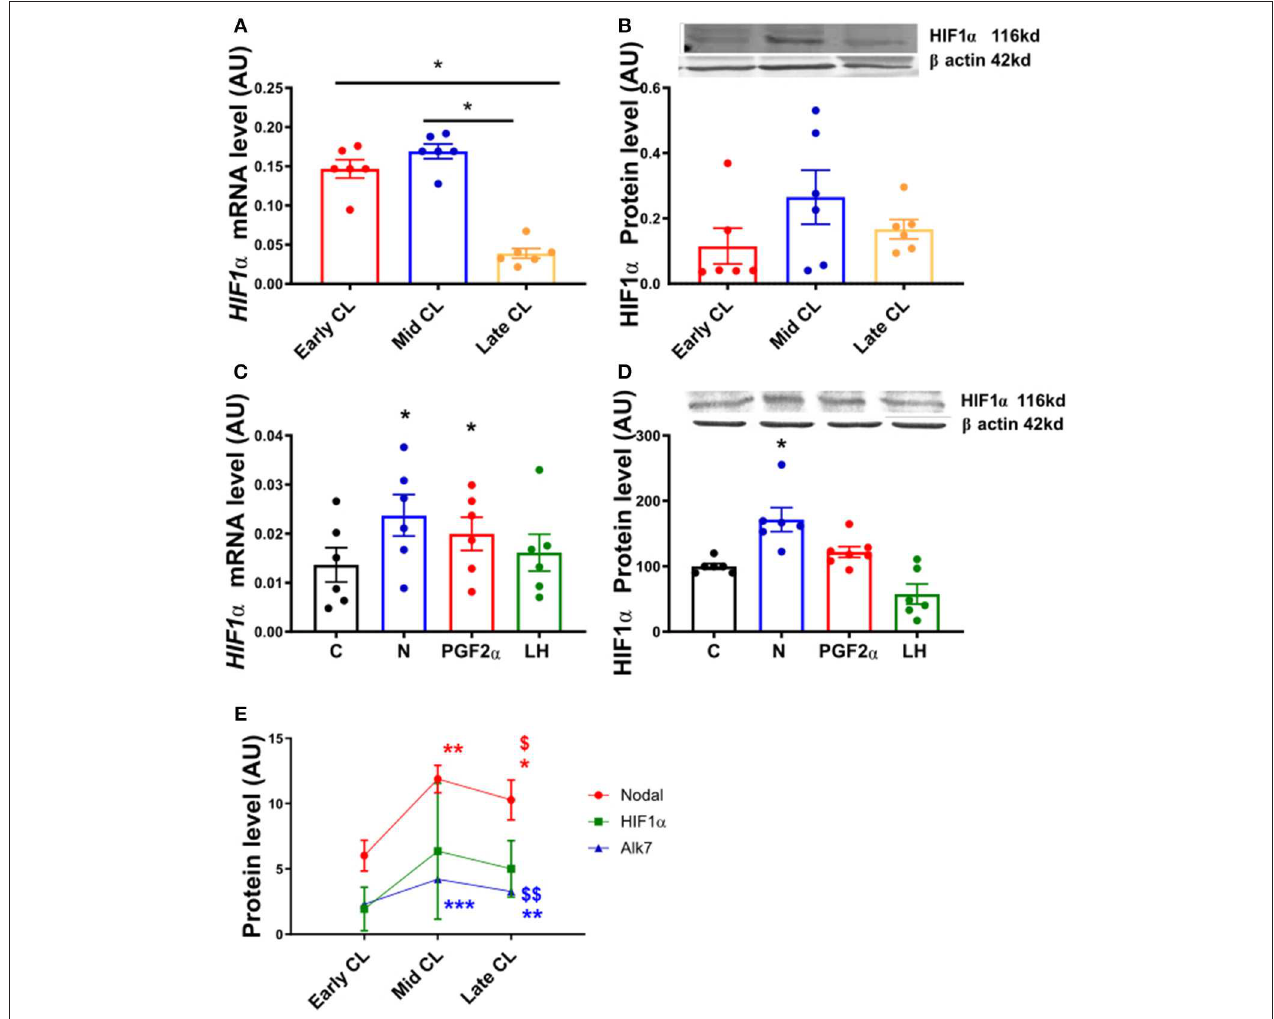
FIGURE 2 | HIF1 α mRNA and protein expression in fresh CL explants and after in vitro culture of mid CL explants. (A) Hypoxia inducible factor 1 α (HIF1 α ) mRNA and (B) HIF1 α protein expression in early, mid and late CL explants ( n = 6). Expression of (C) HIF1 α mRNA and (D) HIF1 α protein after 24h culture: (i) no factor (C, negative control); (ii) Nodal (10ng/mL); (iii) prostaglandin F2 α (PGF 2 α , 10 − 7 M); and (iv) luteinizing hormone (LH, 10ng/mL) ( n = 6). (E) Nodal, HIF1 α , and Alk7 protein level in early, mid and late CL explants. mRNA expression determined by real-time PCR, expression relative to β -2-microglobulin (B2MG) expression. Protein expression determined by western blot, upper panel: representative immunoblot; lower panel: densitometry of protein expression relative to β -actin expression. Values are expressed as means ± SEM in arbitrary units (AU). Statistical differences are marked with asterisks (* p < 0.05). (E) *Significant differences with regard to early CL; $ significant differences with regard to mid CL (one symbol, p < 0.05; two symbols p <